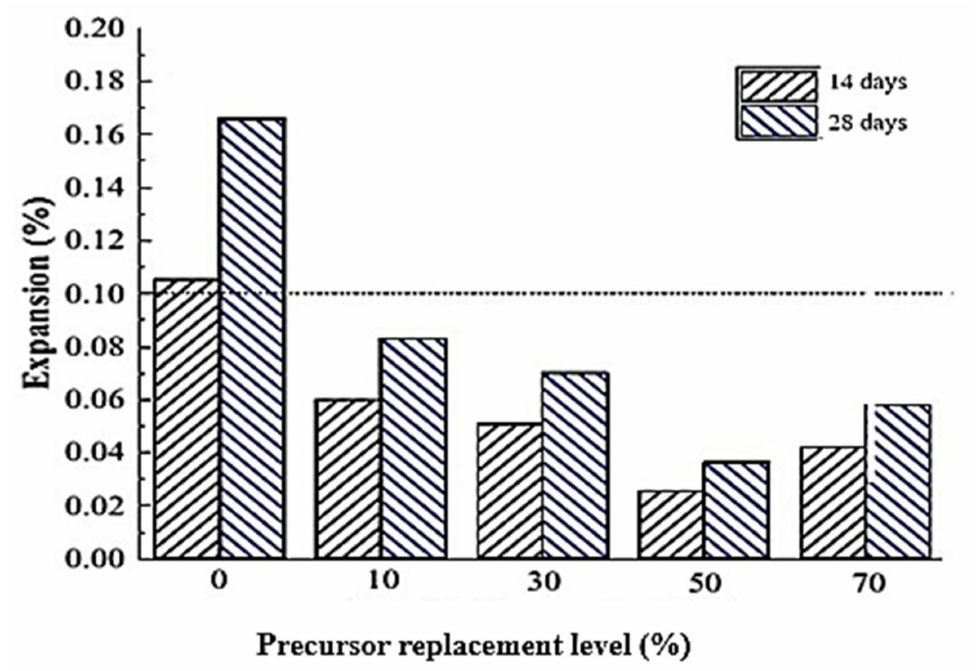
Figure 27. ASR expansion in alkali-activated geopolymer concretes with WG powder (particle size < 32.86 µ m)